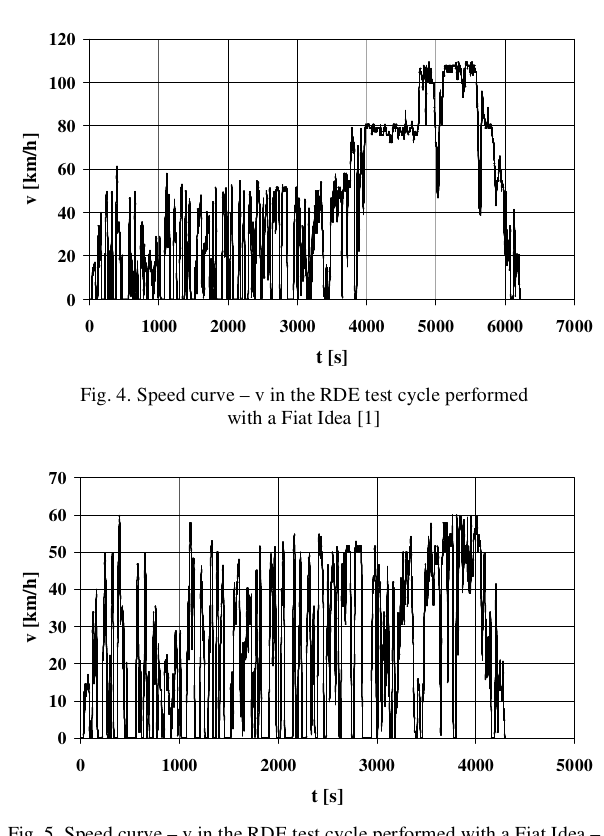
Fig. 5. Speed curve – v in the RDE test cycle performed with a Fiat Idea – drive cycle fragment of the urban drive section – RDE-U